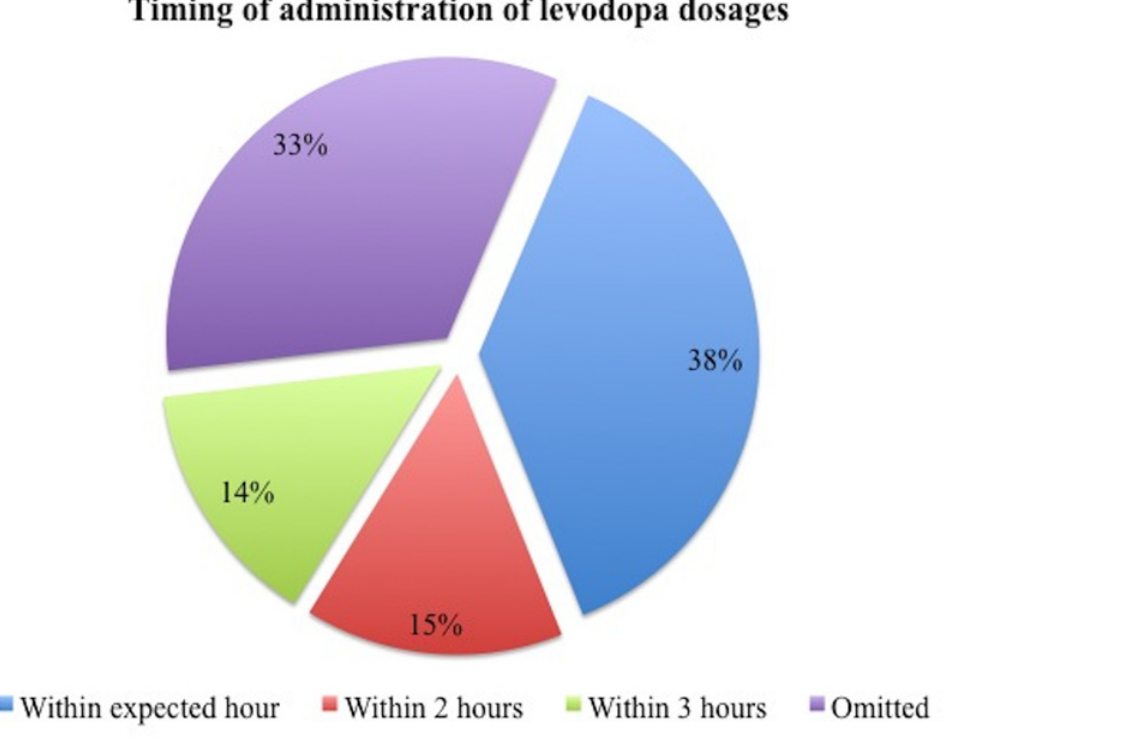
Fig 1. Levodopa delayed or missed dosages (n =